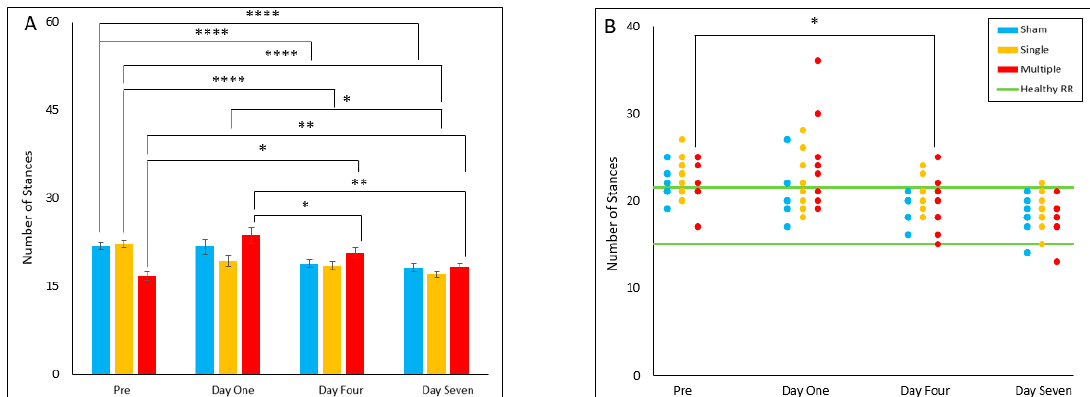
McNemar’s analysis (* p < 0.05, ** p < 0.01, **** p < 0.001).